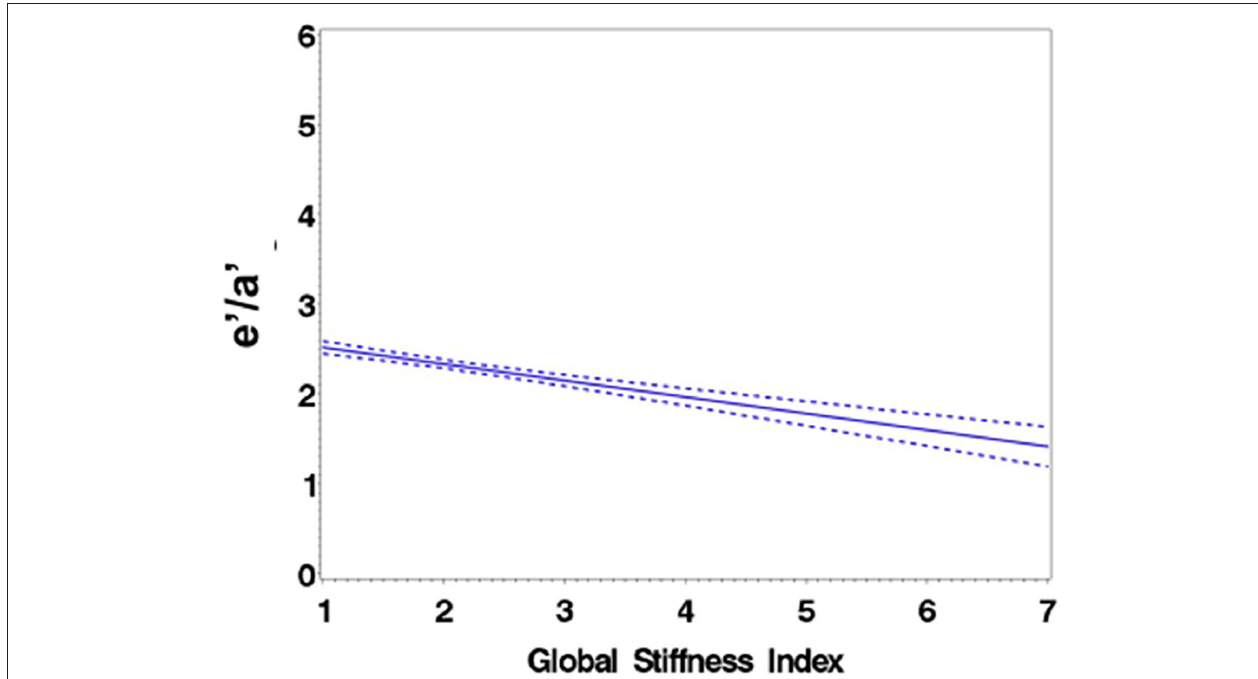
FIGURE 3 | Regression of e ′ / a ′ average on the Global Stiffness Index (mean with 95% confidence limit). R 2 = 0.29; P for slope differs from zero < 0.0001.